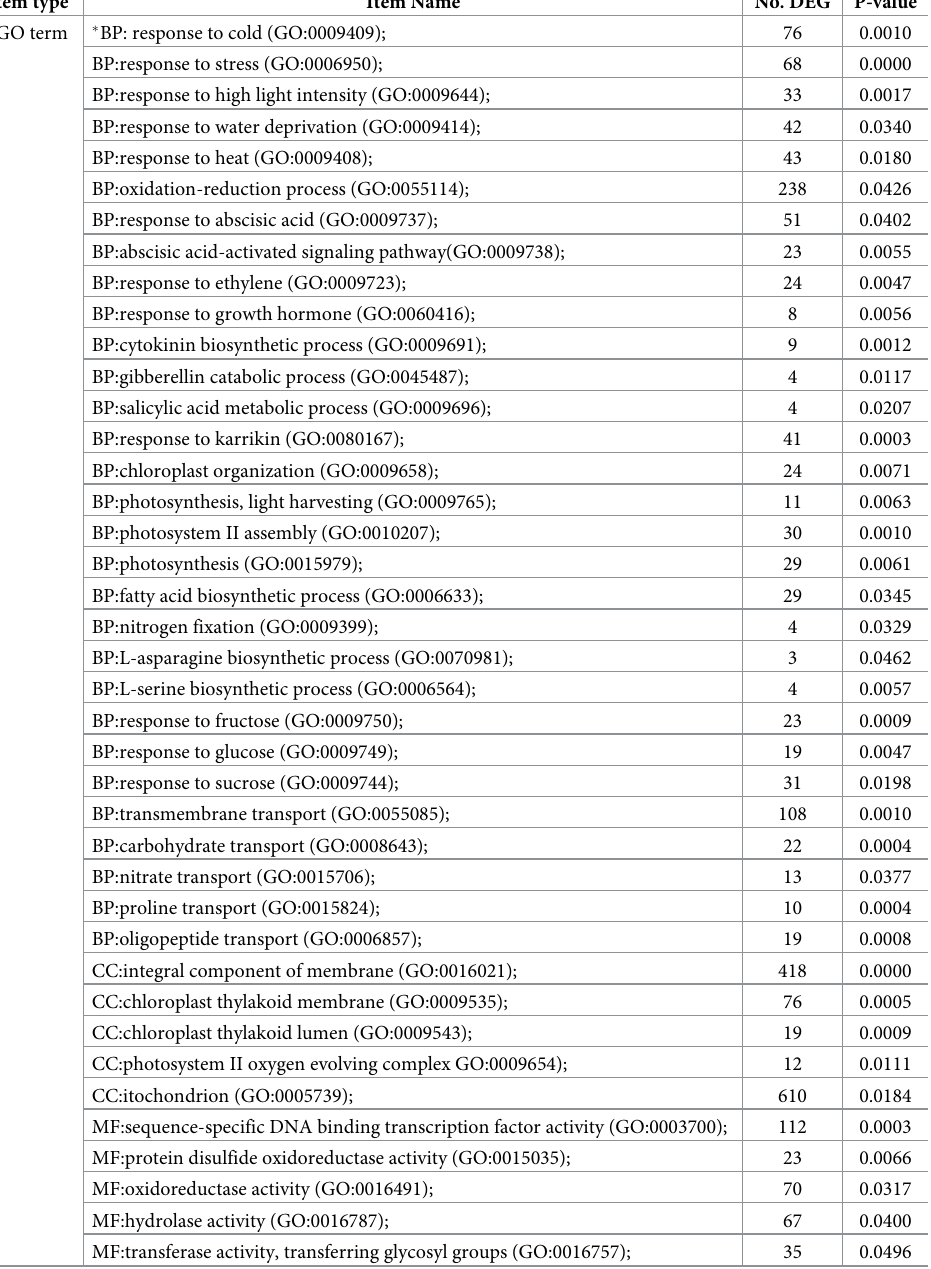
Table) were enriched in the DEGs. The notable enriched terms and pathway are shown in Table 5. These results indicated that Manila grass exposed to low temperature stress for 72h was simultaneously subjected to drought, high light and oxygen stresses, and that crosstalk Table 5. The notable GO terms and KEGG pathways enriched in the DEGs between 72h_CT VS